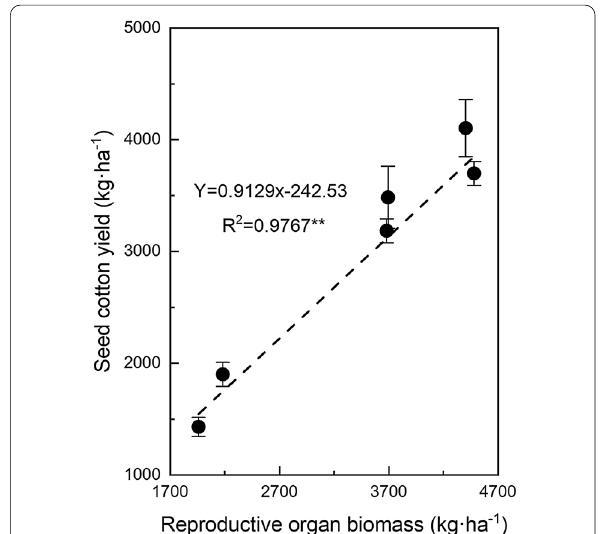
content across treatments and sampling dates (Table 3). Fig. 1 Relationship between reproductive organ biomass and seed